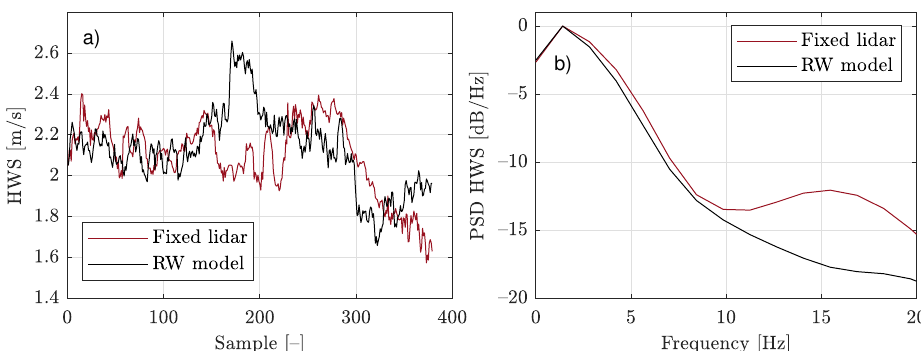
Figure 4. Comparison between the HWS RW model presented in Section 2.5.1 and experimental data: ( a ) Temporal series; and ( b )